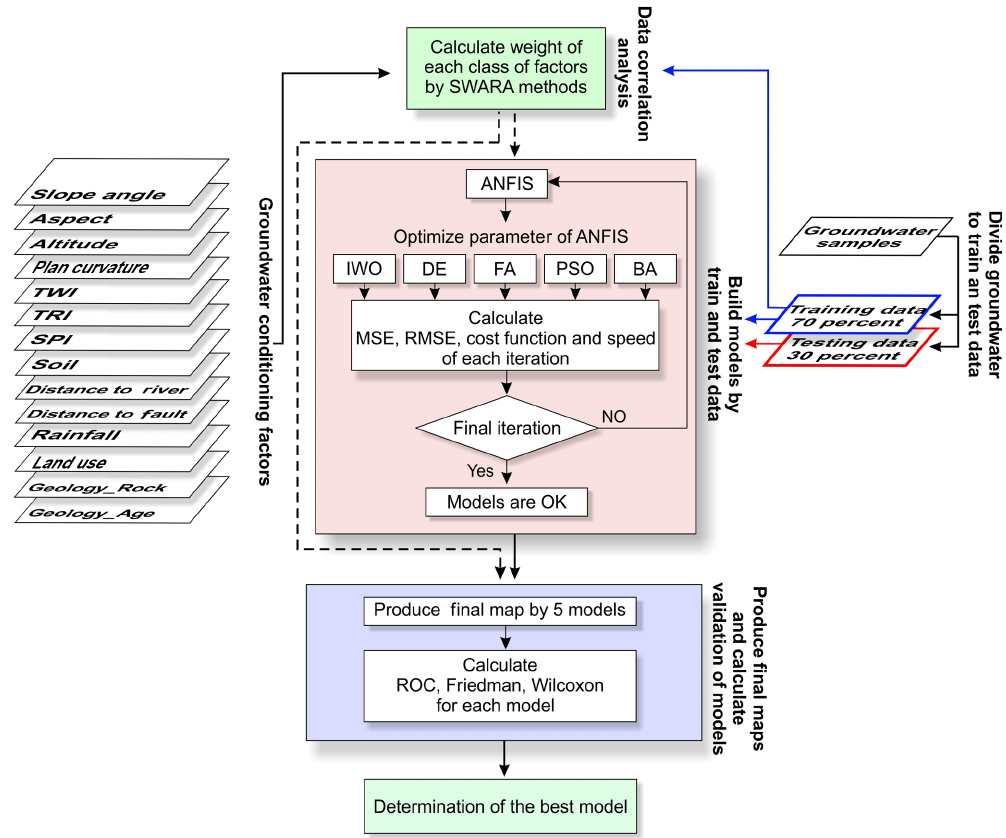
Figure 2. Conceptual model of methodology applied in the current